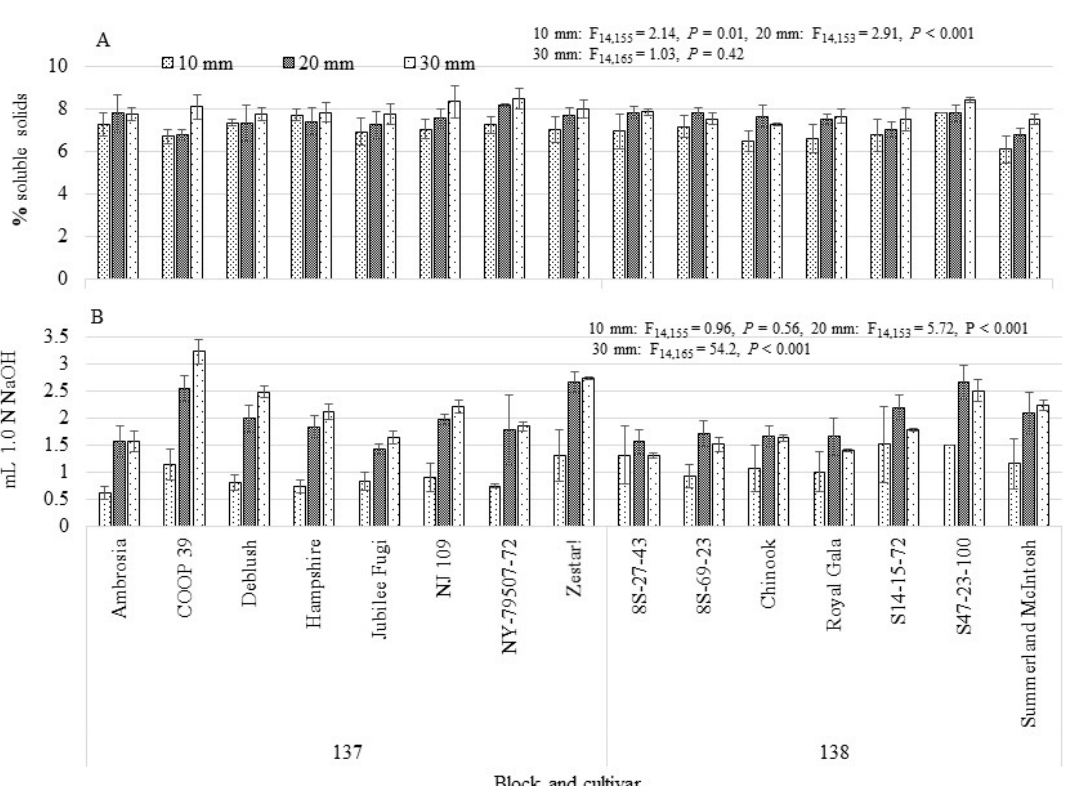
Figure 3. Apple fruitlets, at 10, 20 and 30 mm diameter, collected from 15 cultivars located at the Kentville Research and Development Centre in 2017–2019 and measured for ( A ) mean ( ± SE) percent soluble solids (Brix) and ( B ) mean ( ± SE) mL of 1.0 N NaOH to neutralize 1 mL of juice. Cultivar analyzed for significance within each fruitlet size category.